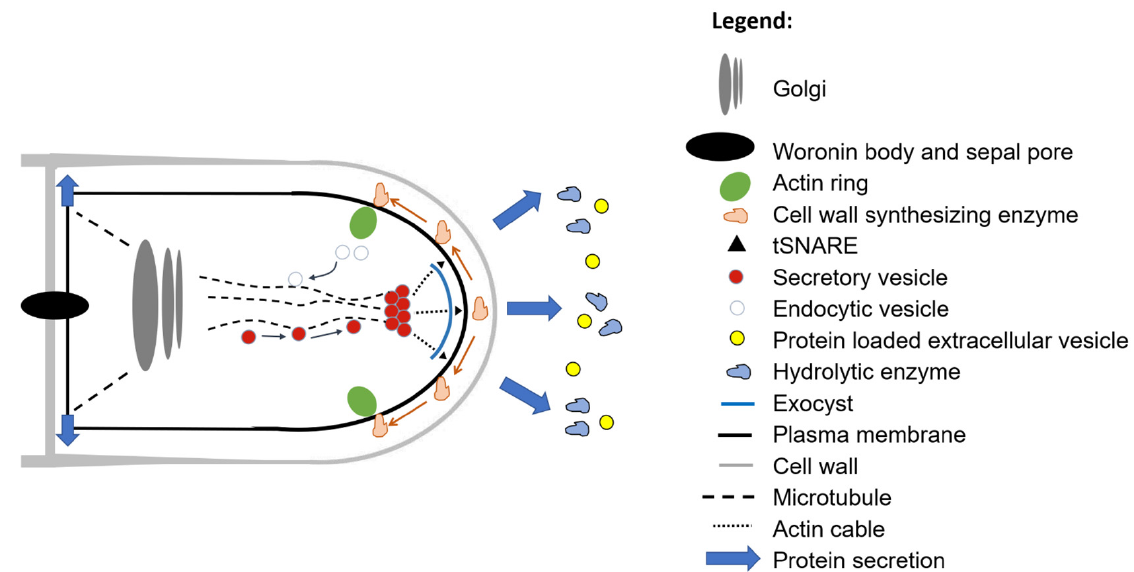
Figure 3. Schematic representation the filamentous fungal protein secretory system. In the classical route, cargo loaded vesicles are transported from the Golgi along microtubules and actin cables to the tip, where they are fused to the plasma membrane by the exocyst complex. Growth of the tip moves cell wall synthetic enzymes toward intercalary hyphal regions (orange arrows), where they are putatively recycled at the actin ring and the endosome system to maintain polarity. Protein secretion does occur at intercalary regions, possibly including the septa. Not shown is secretion by non-classical route(s) which may occur by as yet uncharacterized plasma membrane transporters. The production of extracellular vesicles is also not yet fully understood. Note that key differences to the secretory machinery (e.g., protein components of SPK, exocyst) exist between phyla, and are still being elucidated. Note that not all components are show and diagram is not to scale. Adapted from [3].